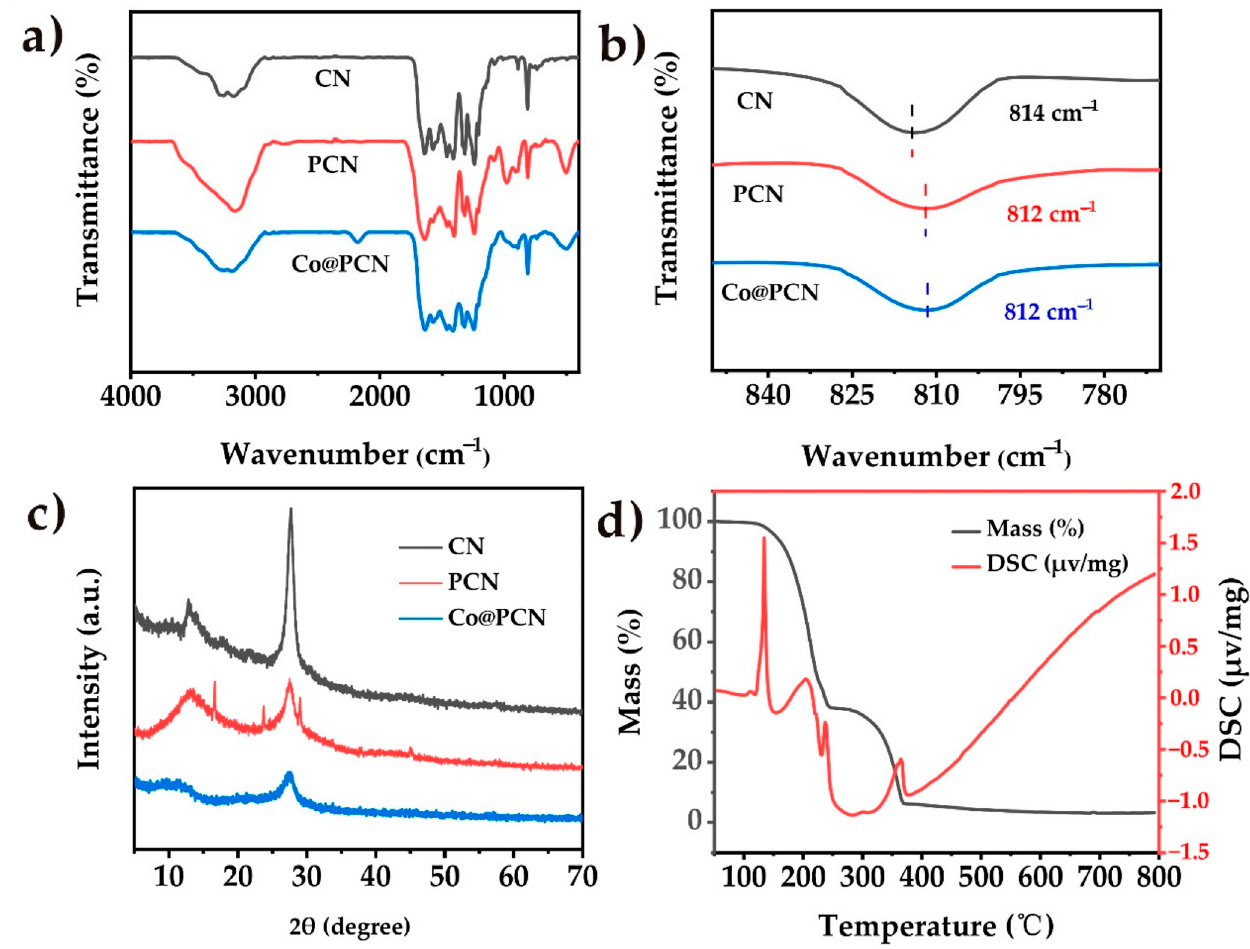
Figure 1. ( a ) FT-IR spectra and ( c ) XRD patterns of CN, PCN, and Co/PCN. ( b ) A closer investigation over the absorption peak centered at around 814 cm − 1 . ( d ) TG-DSC curves of the mixture of urea and (NH4) 2 · HPO 4 in air